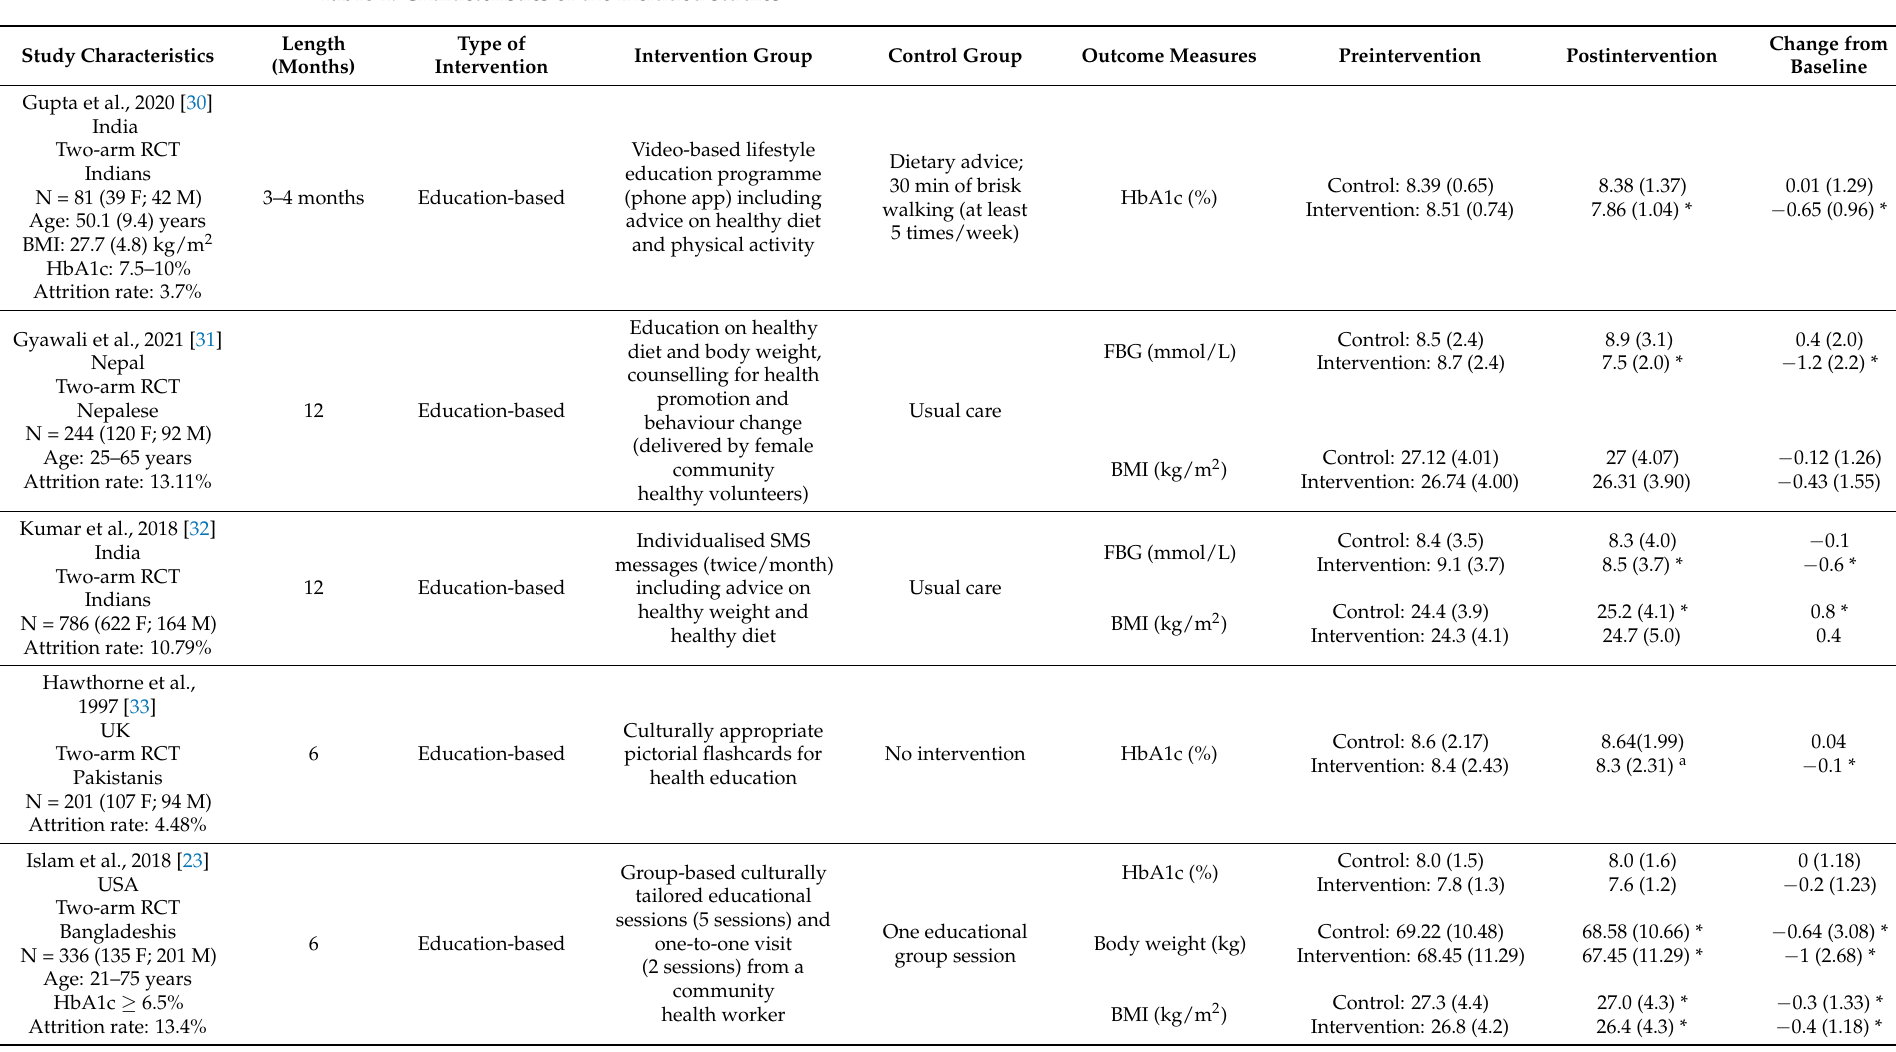
Table 1. Characteristics of the included